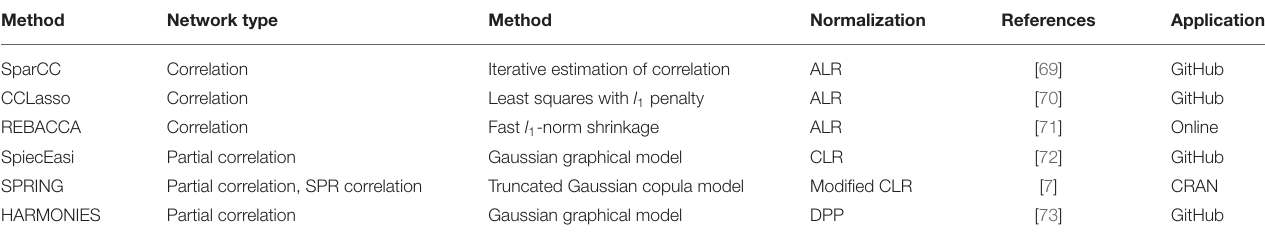
TABLE 8 | Summary of methods for network analysis in microbiome studies.